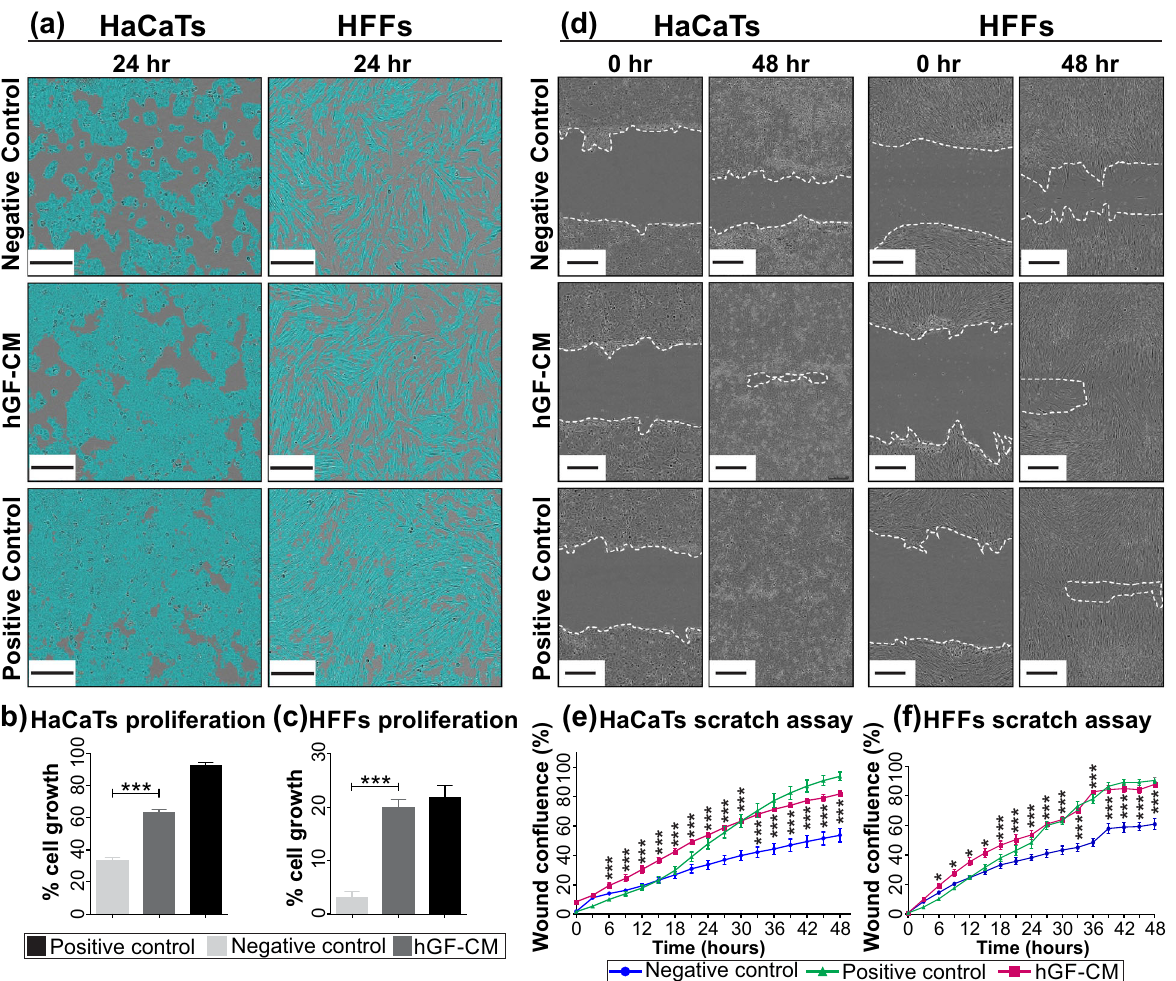
Fig. 2 The effect of hGF-CM on fi broblast and keratinocytes. a Representative images of HaCaTs and HFFs 24 h after treatment with hGF-CM versus positive and negative control media. Scale bars represent 0.3 mm. b , c The effect of hGF-CM on the proliferation of ( b ) HaCaTs and ( c ) HFFs was quanti fi ed by Incucyte proliferation assay 24 h post seeding. n = 6. d Representative images of scratch assays show scratches immediately after the scratches had been made and then after 48 h. Scale bars represent 0.3 mm. e , f The effect of hGF-CM on the migration of ( e ) HaCaTs and ( f ) HFFs was measured using a scratch assay. n = 6. All data is represented as mean ± SEM. * p < 0.05, ** p < 0.01, *** p < 0.001, ns = nonsigni fi